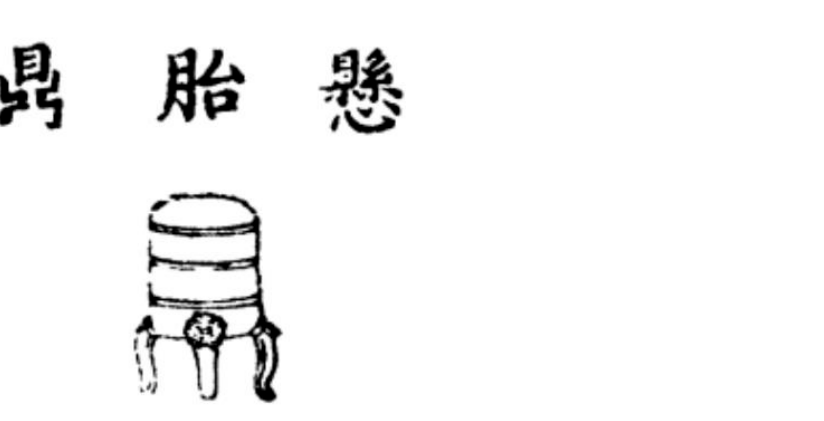
Figure 3. The Suspending Fetus Tripod in Danfang baojian zhi tu (Zhang 1988, p. 713a).